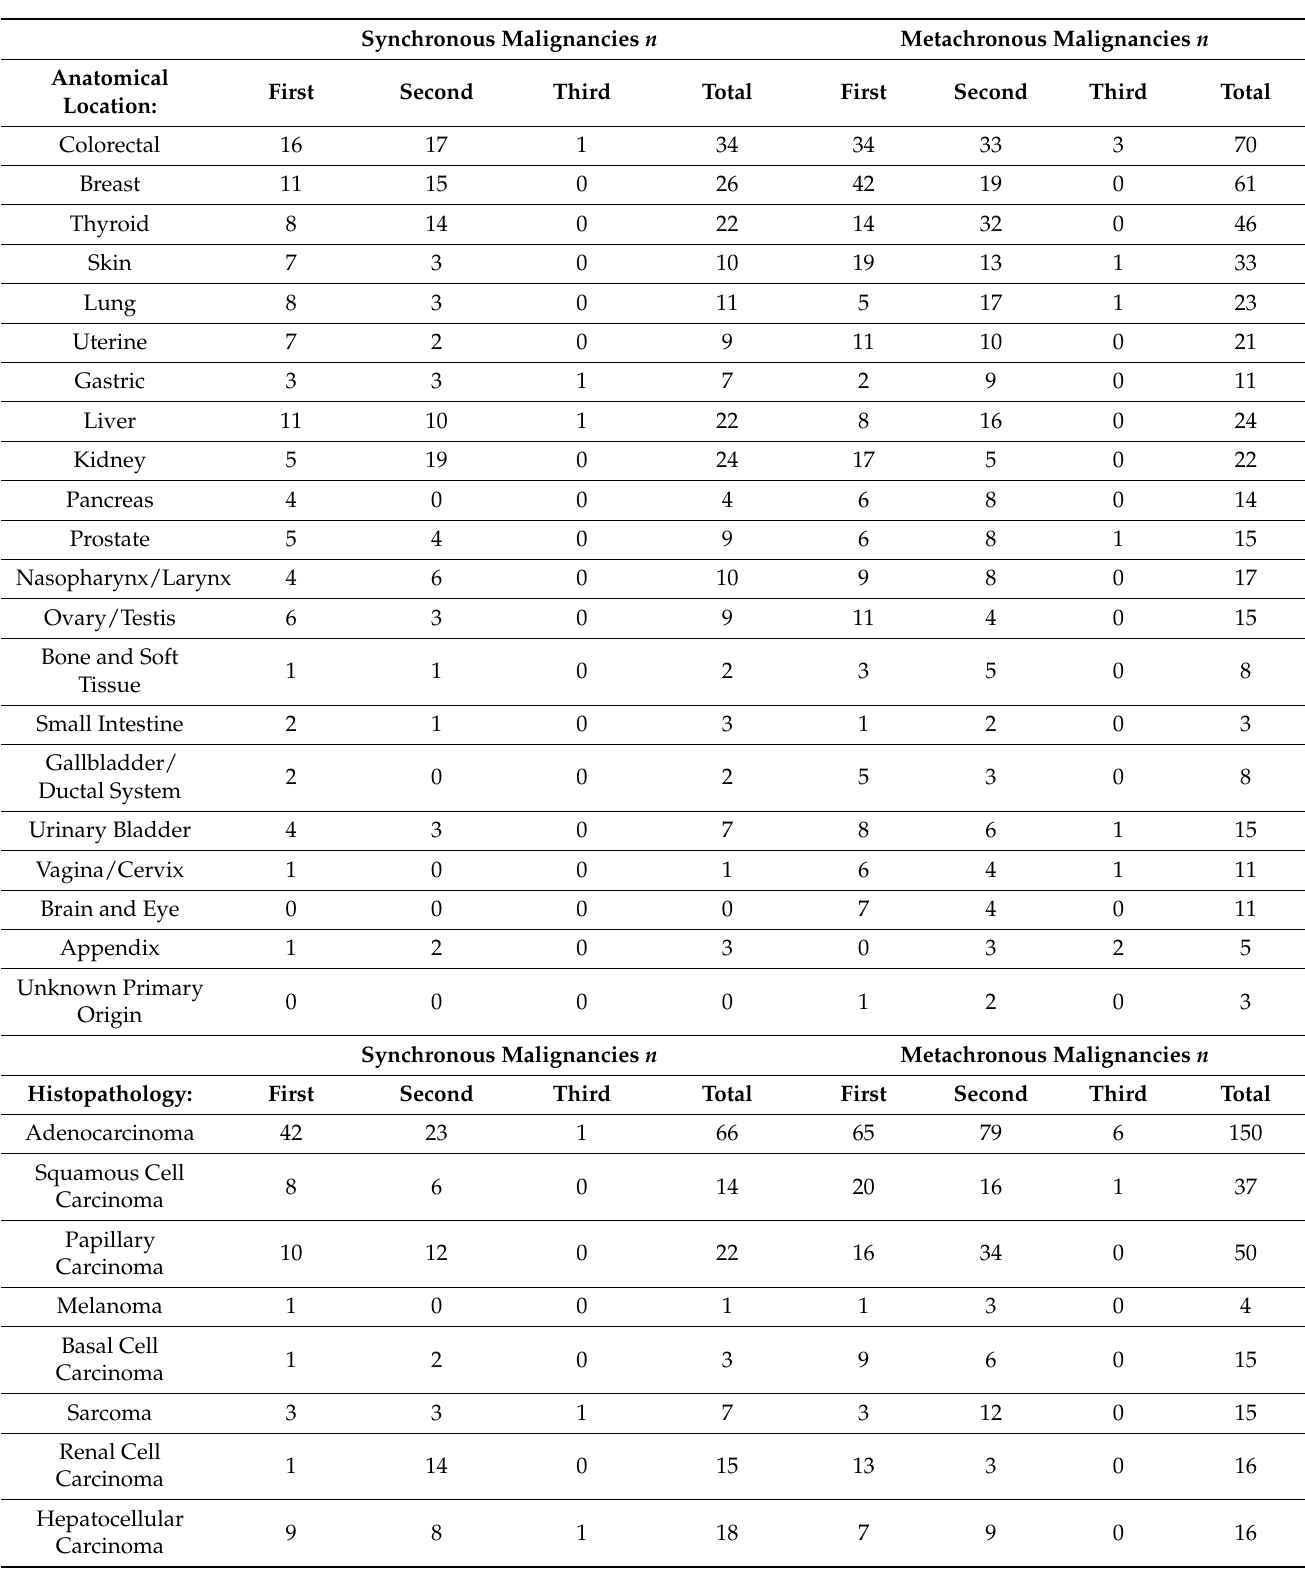
Table 2. Anatomical Distribution of Multiple Primary Malignancies and the Histopathology Based on the Time Interval between the 1st and 2nd